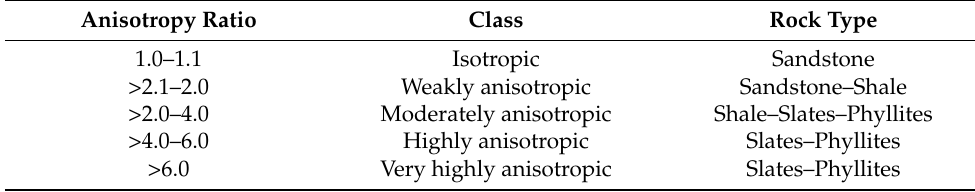
Table 6. Anisotropy classification according to uniaxial compressive strength for different fine-grained rocks [32].